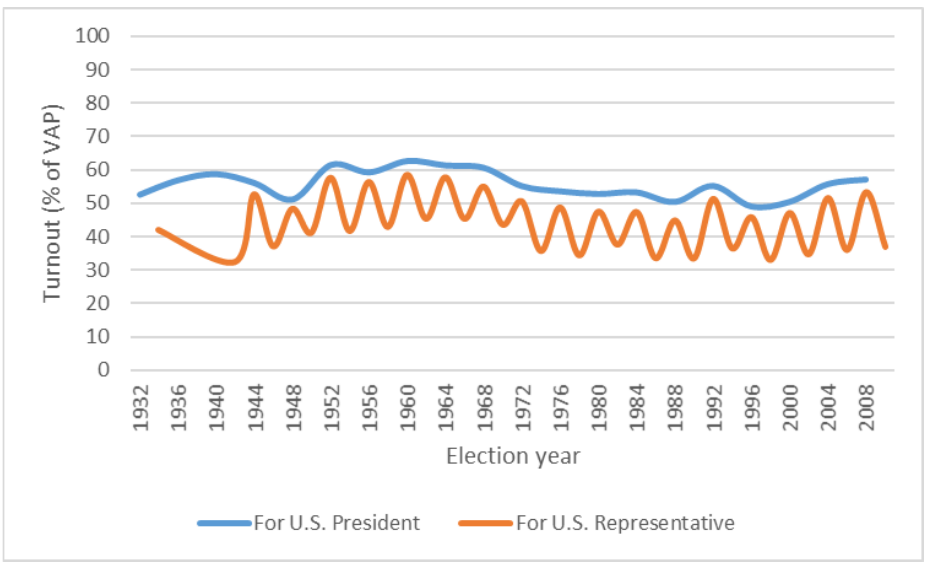
The data used to create this graph is adapted from the Huf fi ngton Post’ s (2013) poll database on congressional approval. This data originates from 465 polls from various pollsters including Gallup, Fox, and YouGov/Economist. This graph is created by curve- fi tting (moving averages) approval and disapproval ratings from the 465 polls in the database at the time it was accessed. It should be noted that polls surveyed different populations (adults, likely voters, registered voters) using different survey methods (e.g. phone and internet). Additionally, it should be noted that I plotted the poll release dates along the primary axis rather than the polling period of the